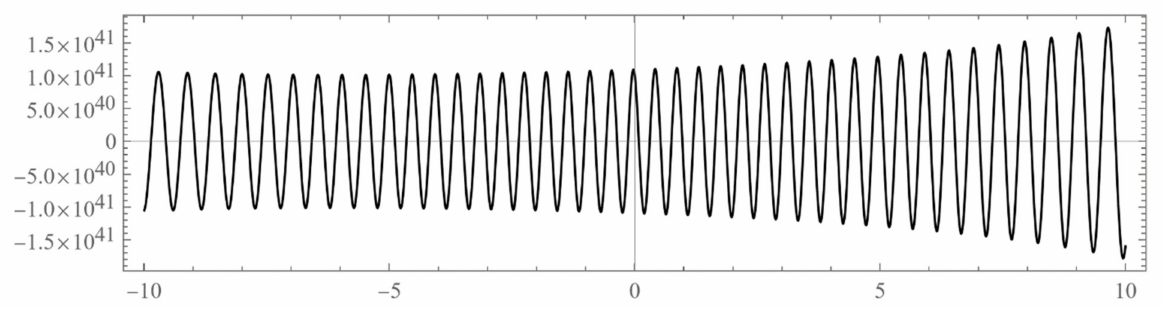
Figure A6. The un-normalized wavefunction (cid:101) ψ ( x , E ) for E = 3 λ 2 /2, which is a forbidden energy outside the band. We took N = 100. Note the unbounded oscillations everywhere.